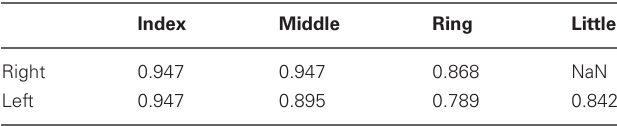
Table 2 | Results of the clustering analysis in the 4-dimensional space with four fingers as